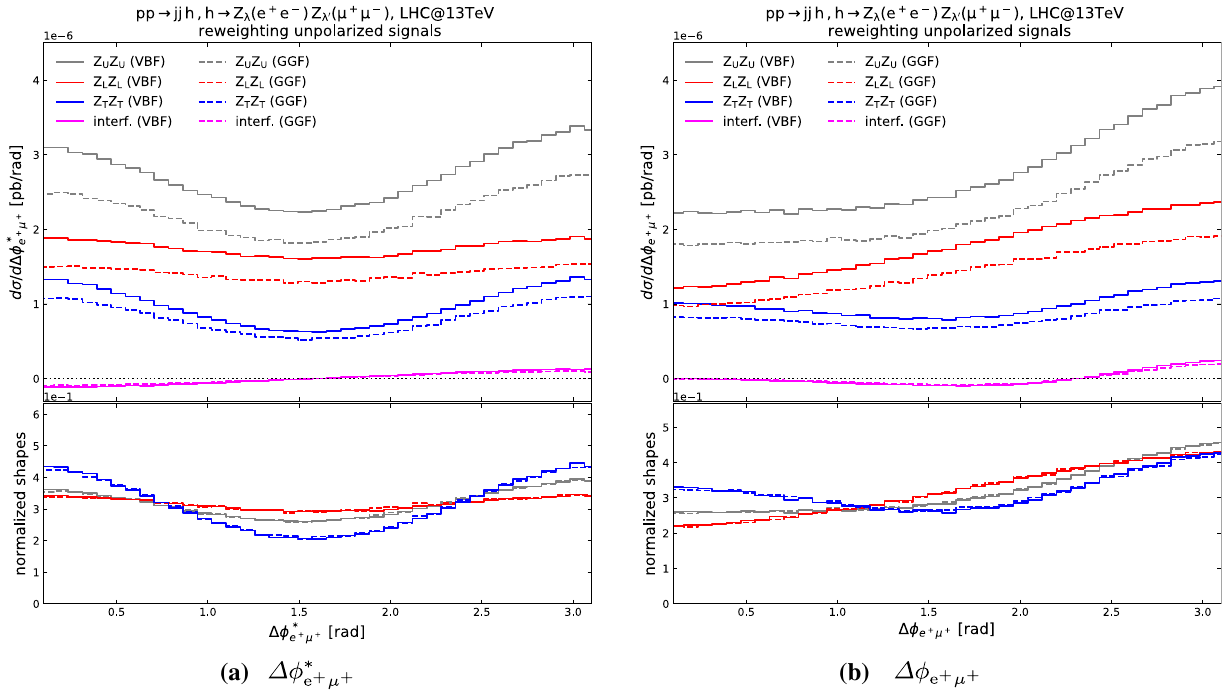
Fig. 4 Distributions for Higgs production in GGF (dashed curves) and VBF (solid curves) at the LHC@13TeV: difference between the azimuthal decay angles of the positron and of the antimuon, computed